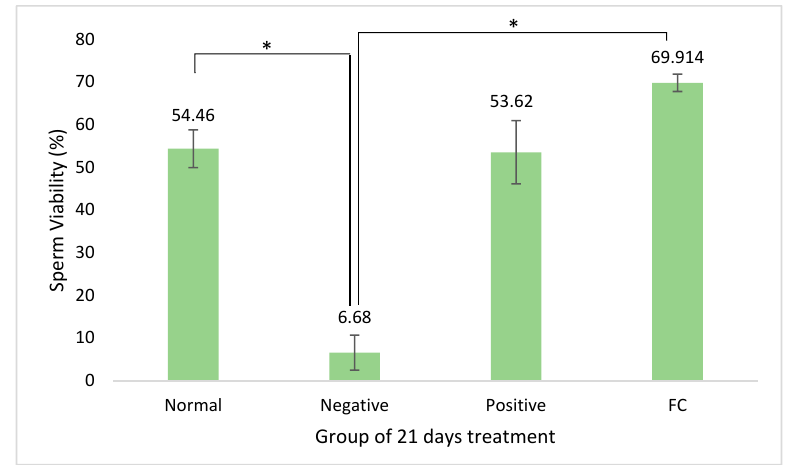
Figure 4. Sperm viability (%) of rats from normal (normal group with distilled water), negative (diabetic group with distilled water), positive (diabetic group with 300 mg/kg metformin), and FC (diabetic group with 400 mg/kg Ficus carica aqueous extract). Symbol “ * ” represents significant difference ( p < 0.05).